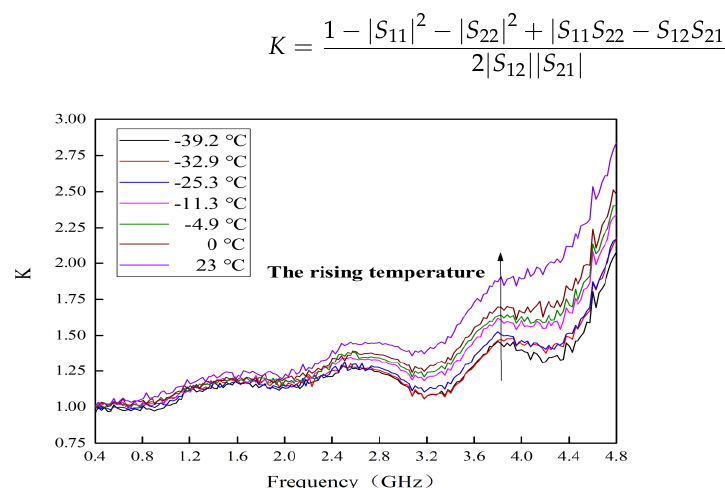
Figure 9. Measured curves of stability factor with typical alpine temperatures.